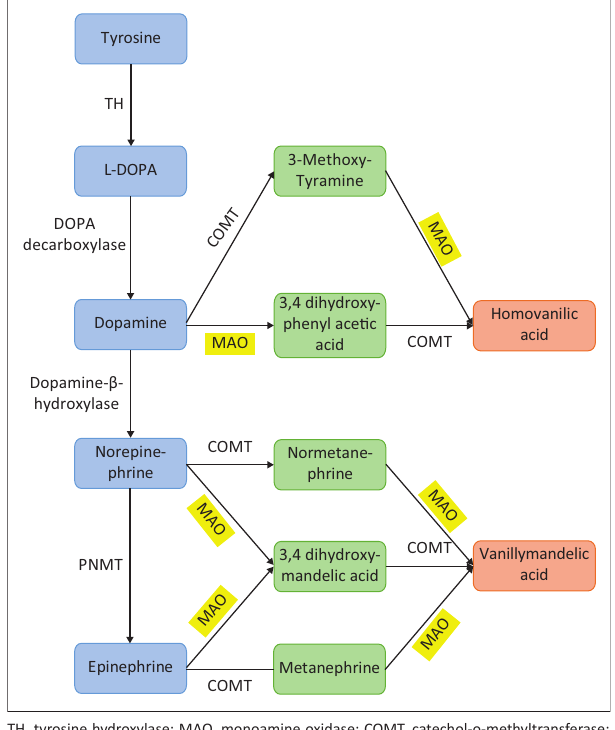
FIGURE 1: Metabolic pathway of